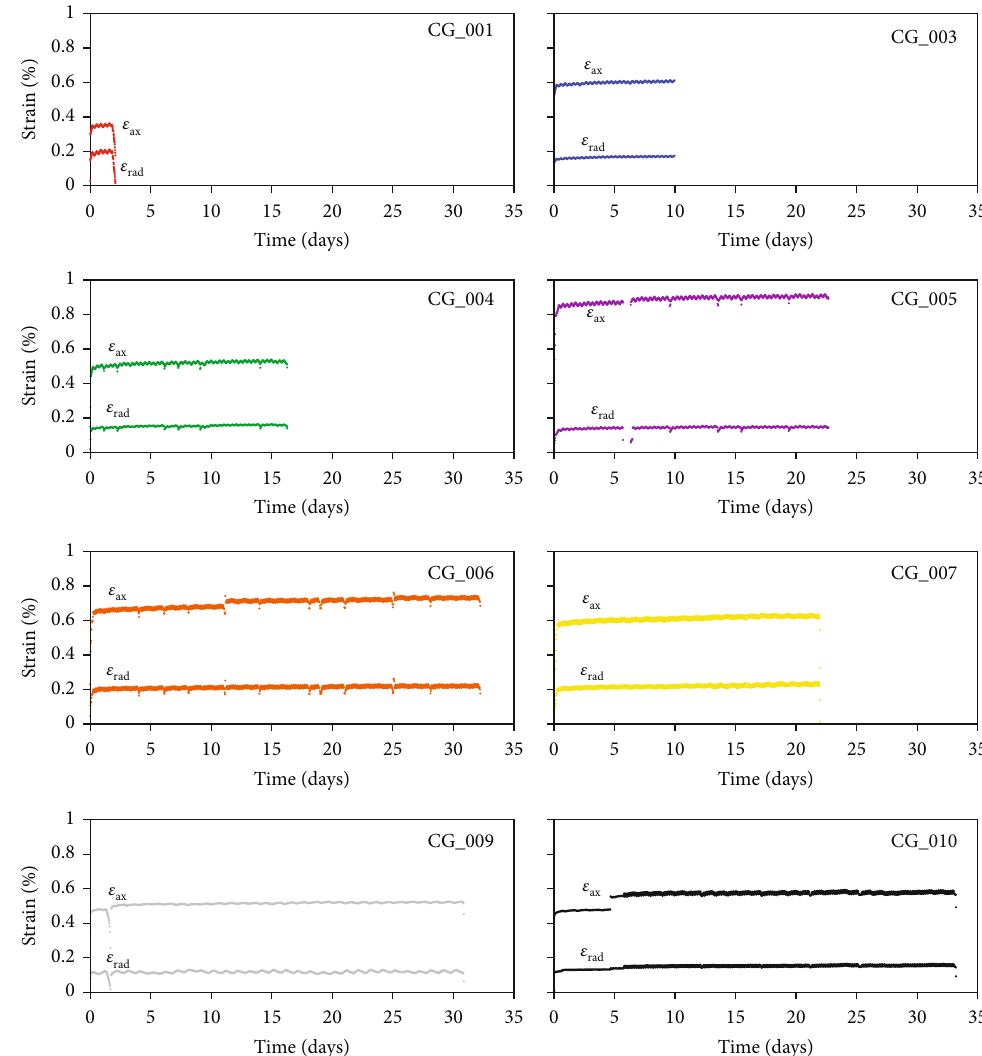
Figure 4: Axial and radial strains for duration of each